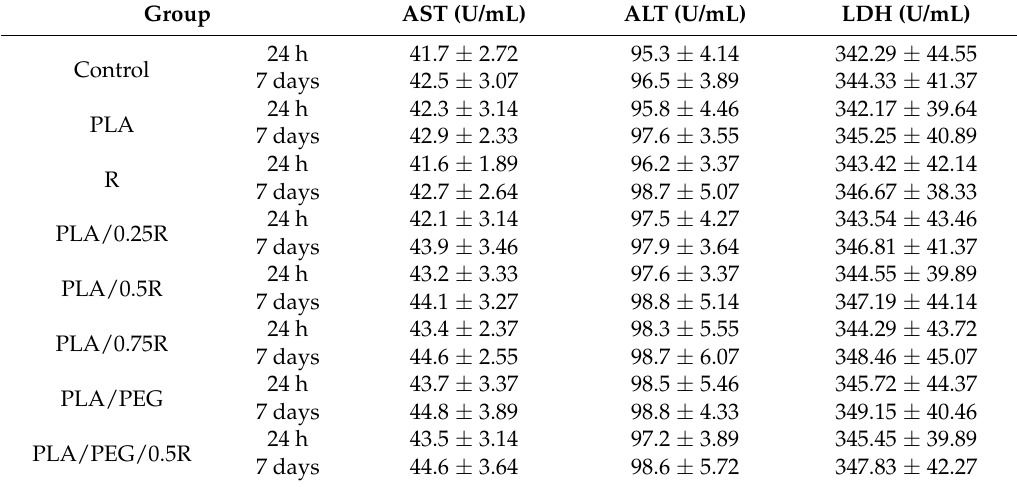
Table 13. The effects of PLA-based materials containing rosemary ethanolic extract on the activity of AST, ALT, and LDH. Values were expressed as mean ± S.D. for six rats in a group.